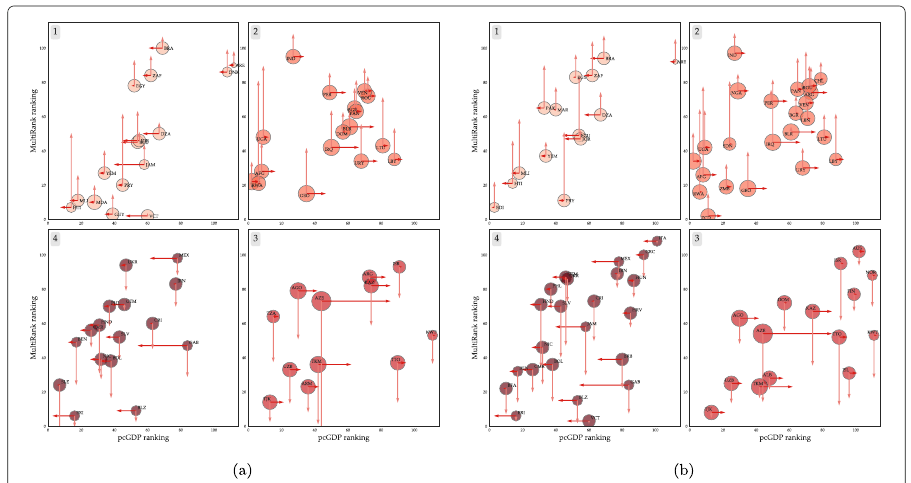
Fig. 10 Evolution of ranking over time of pcGDP (x-axis) and MultiRank (y-axis). MultiRank calculated with a = 1 in ( a ) and with a = 0 in ( b ). Countries have been split by the direction of evolution of MultiRank and pcGDP; starting from the top left corner clockwise: 1) increase/decrease, 2) increase/increase, 3) decrease/increase, 4) decrease/decrease